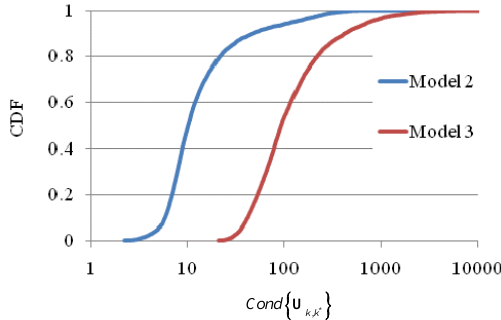
Figure C1. Cumulative distribution functions (CDFs) of parame- ter Cond (cid:8) U k,k ∗ (cid:9) (condition number) calculated from radiometer data of the AERONET station in Minsk for two- and three-fraction aerosol models, Model 2 and Model 3,